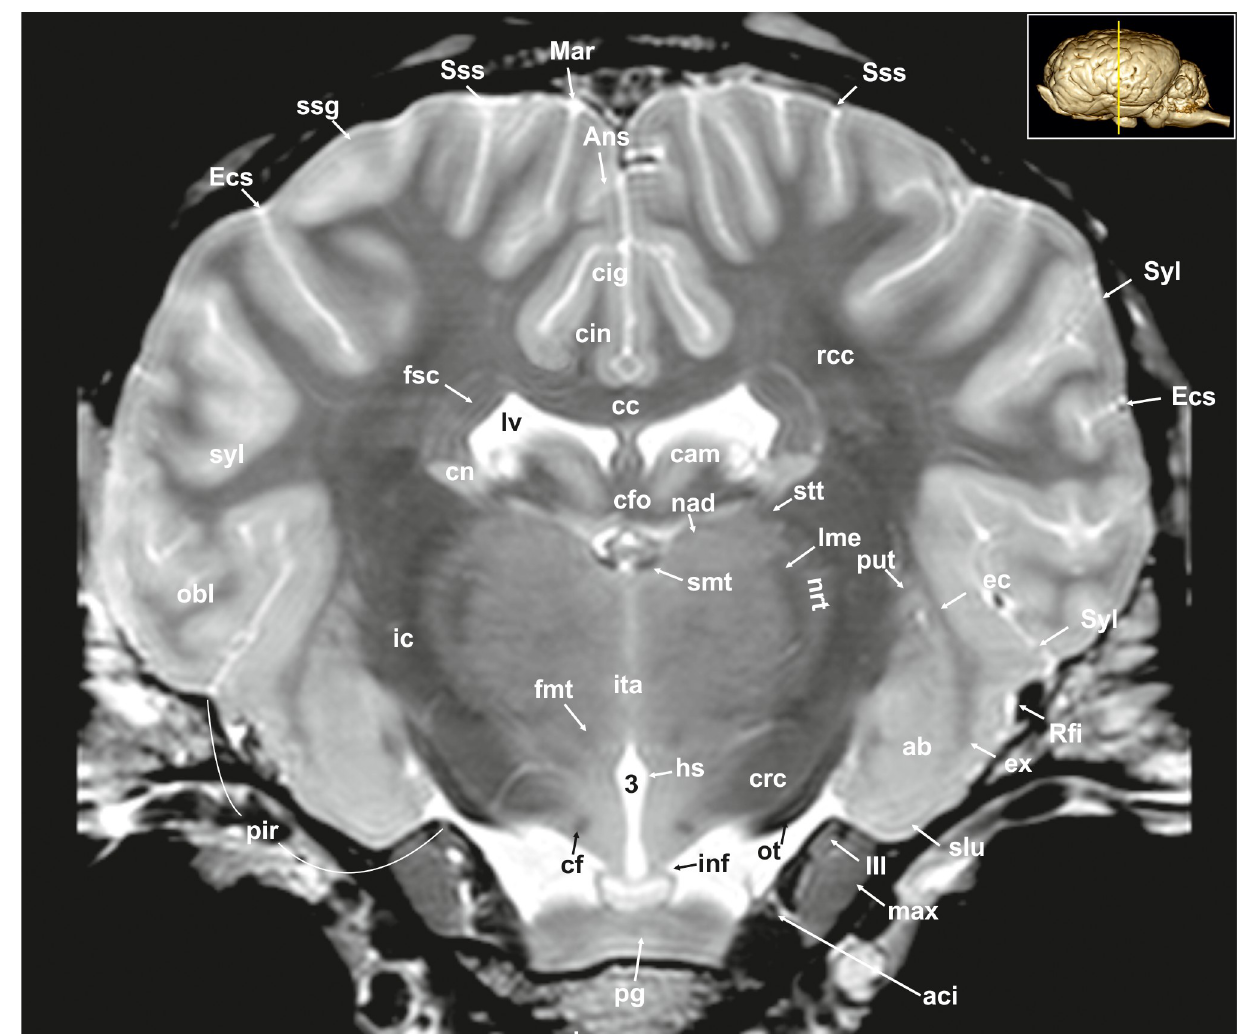
Fig 7. Transverse magnetic resonance image of the equine brain on the level of the amygdala. ab: amygdaloid body, aci: internal carotid artery, Ans: ansate sulcus, cc: corpus callosum, cig: cingulate gyrus, cin: cingulum, cf: column of fornix, cfo: corpus of fornix, cn: caudate nucleus (tail), crc: